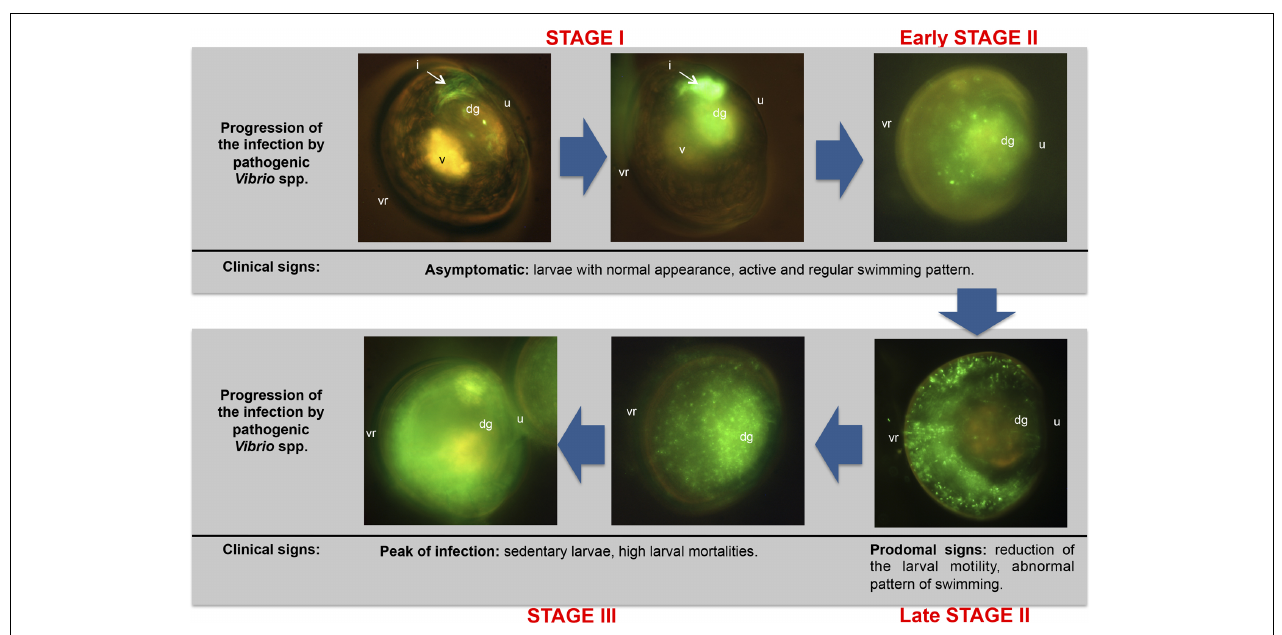
FIGURE 4 | Progression of the vibriosis infecting R. philliphinarum larvae with GFP-tagged pathogenic vibrios. dg: digestive gland; i, intestine; u: umbo; v: vellum; vr: ventral region. Adapted from Dubert et al.